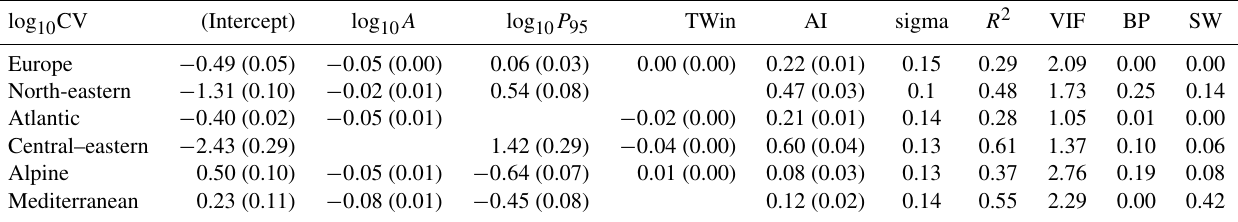
Table A2. Regression coefficients (standard errors), model error variance, R 2 , and maximum variance inflation factor (VIF) of regional regression models for CV. The last two columns contain p values for the Breusch–Pagan and Shapiro–Wilk tests. Statistically significant results (small p values) indicate heteroscedasticity and non-normality of the residuals, respectively. All numbers are rounded to two digits. For details on VIF, see e.g. Weisberg (2005), and for details on the hypothesis tests, see e.g. Helsel et al. (2020).